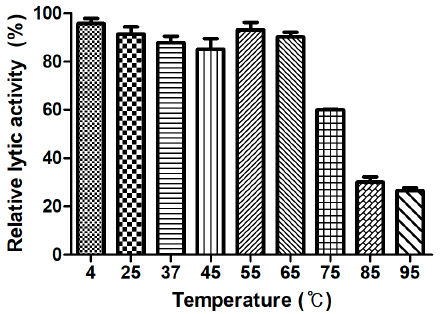
Figure 4. LysCPS2 thermal stability. LysCPS2 was incubated at different temperatures for 10 min,